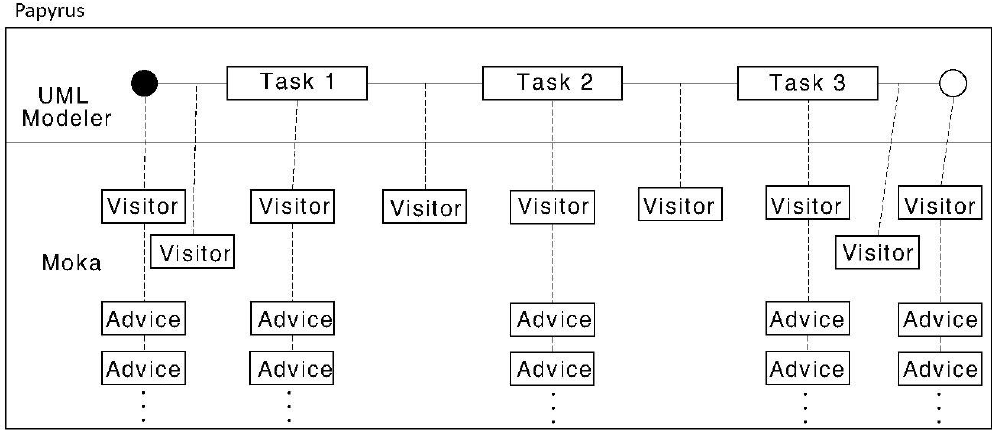
Figure 3. Visitors and advices connected to Papyrus (UML) model.